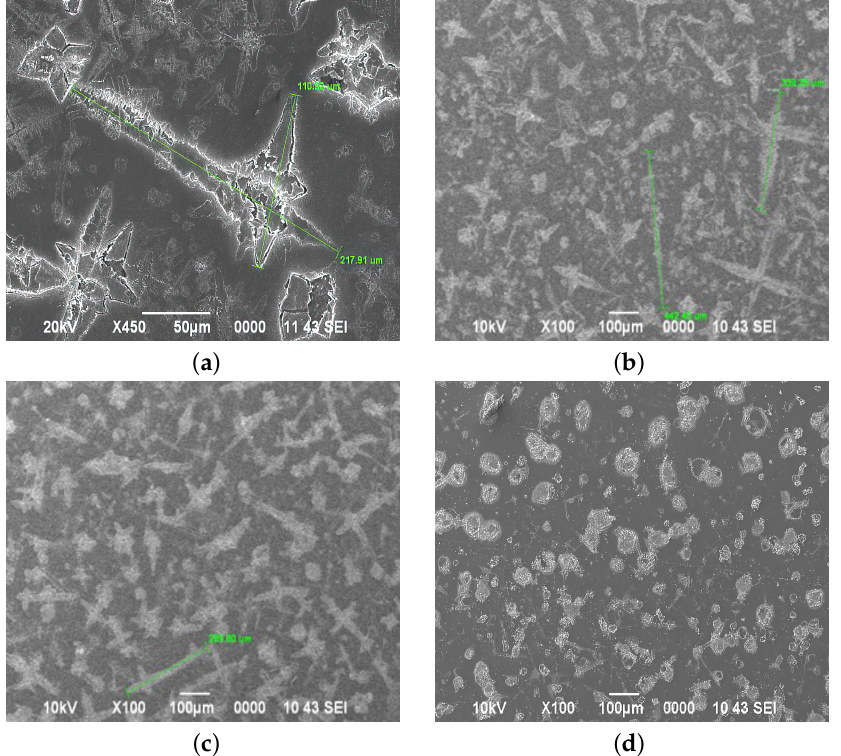
Figure 5. The surface morphology of films deposited from a film-forming system with pH ( a ) 1.47,